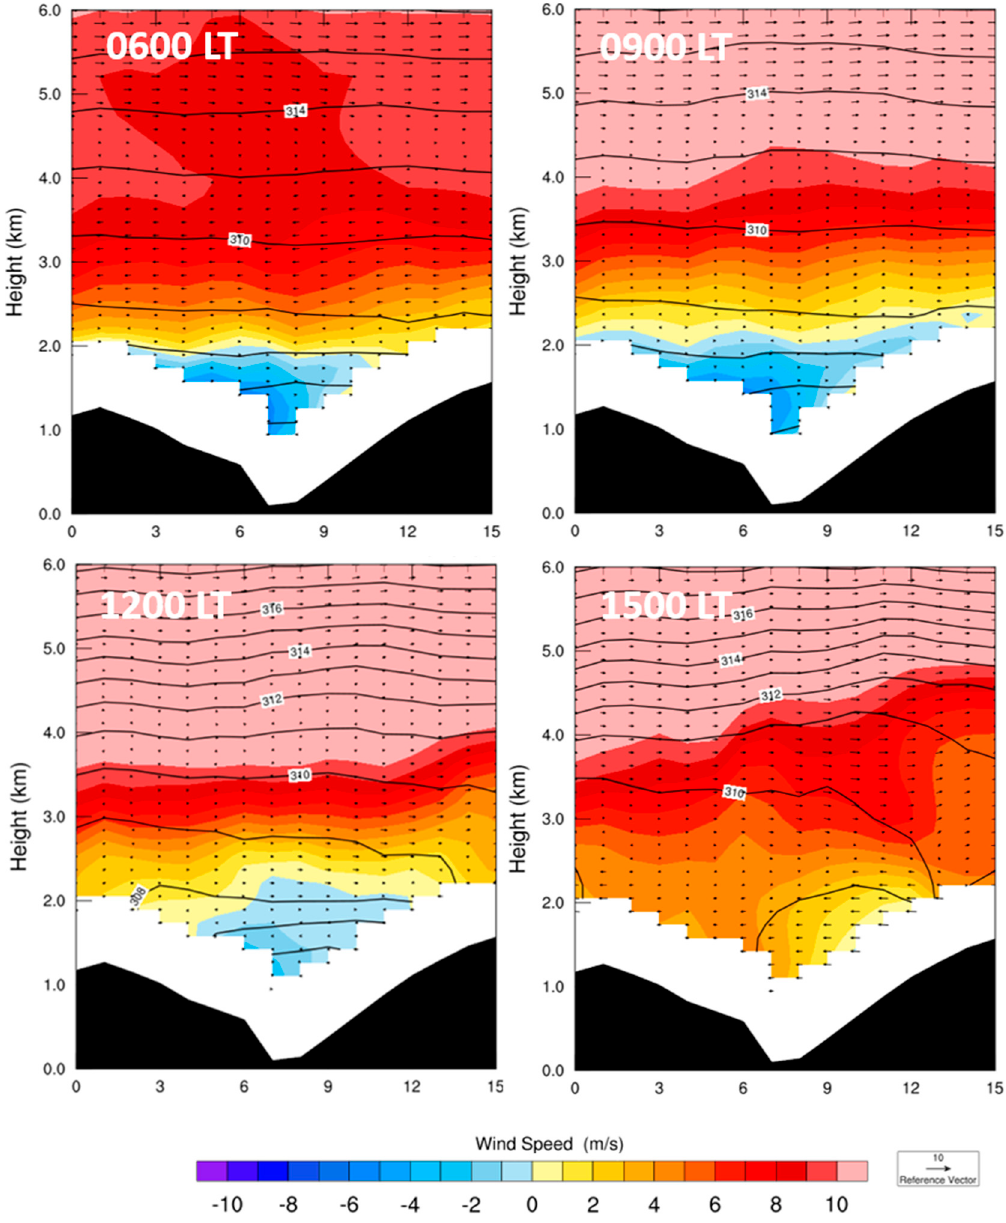
Figure 11. Cross-valley vertical profiles of wind and potential temperature simulated in the 1.33 km domain for event day 17 August. Wind vectors indicate wind in the y - z plane. Wind speed is the u-component of the wind; negative values indicate easterly flow. Into the page is west with the north canyon wall on the right. Only the lowest 6 km are shown.